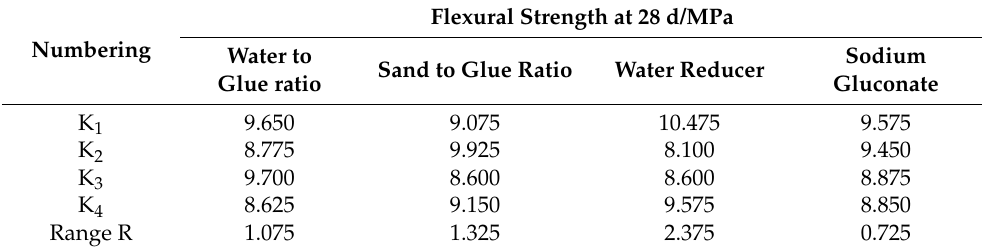
Table 13. Influence of various factors on flexural strength after 28 d.